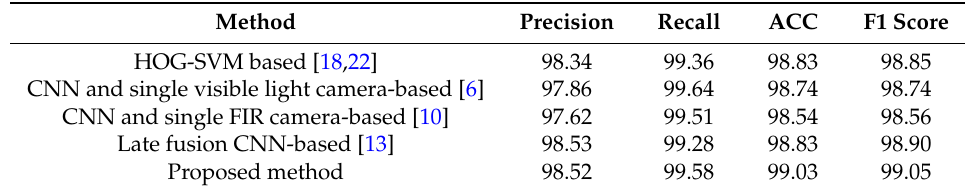
Table 13. Comparisons of classification accuracies with OSU color-thermal database based on precision, recall, accuracy, and F1 score (unit: %).